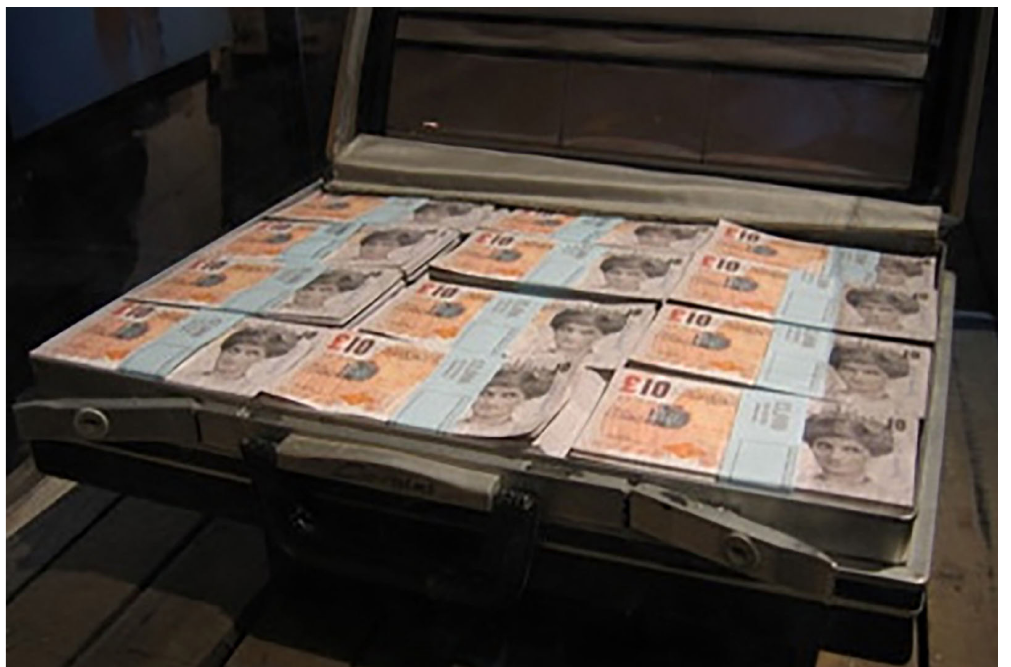
Offset lithograph printed in colours on both sides of the sheet, signed in black pen, 450 by 315mm 17¾ by 12⅜in.